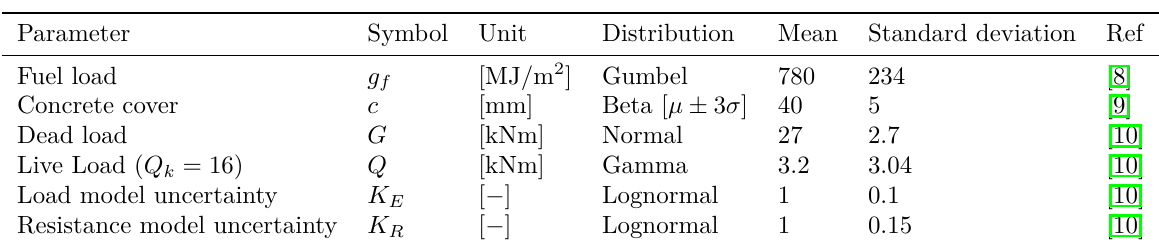
Table 2. Distributions of the parameters used to calculate the failure probability.